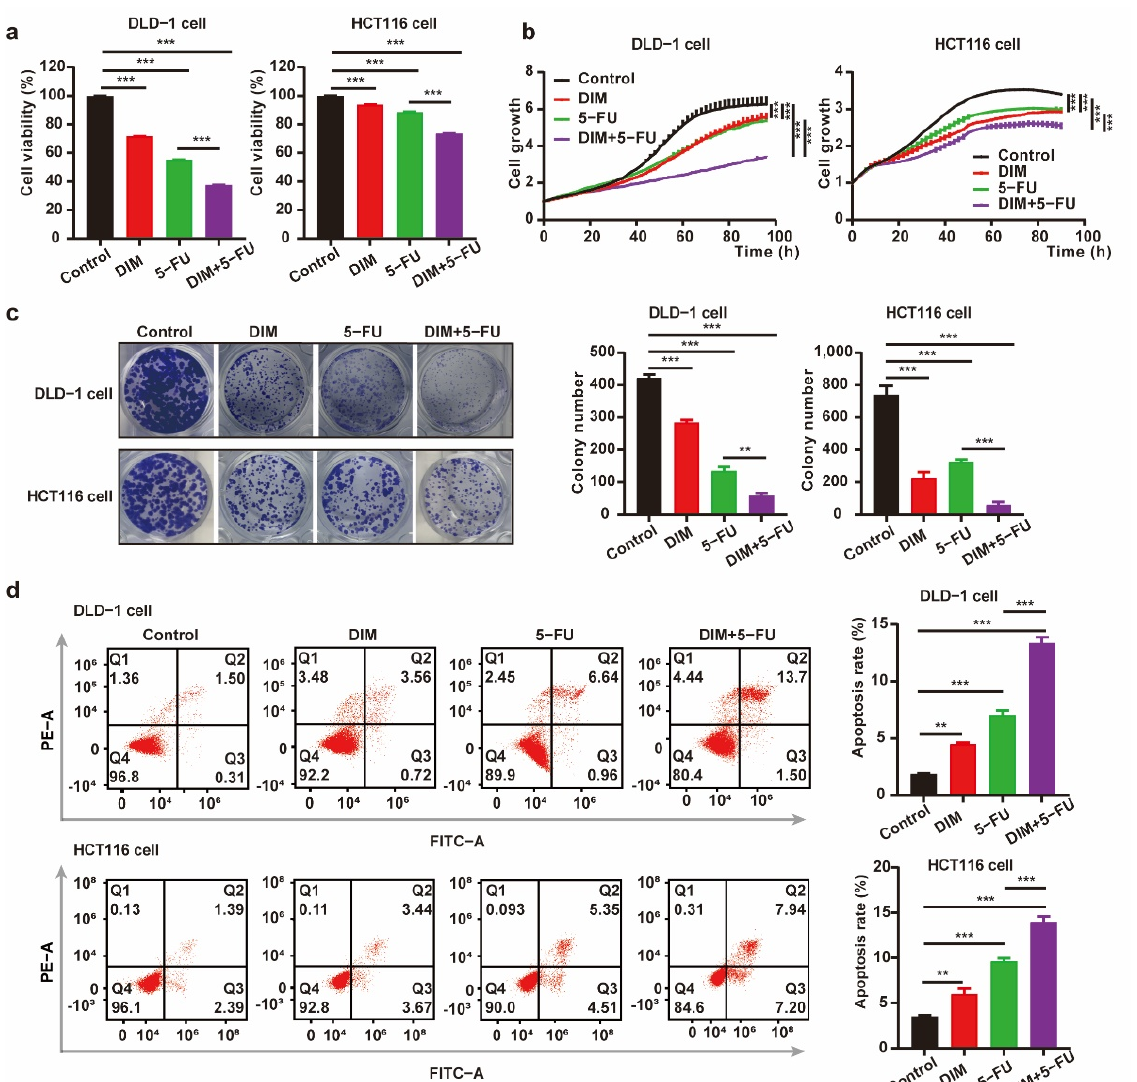
Figure 4. DIM increases the chemosensitivity to 5-FU and potentiates 5-FU-induced suppressive effect on CRC cells. ( a ) Cell viability of CRC cells was detected using CCK-8 assay. DLD-1 cells (DIM, 30 µ M; 5-FU, 10 µ M) and HCT116 cells (DIM, 20 µ M; 5-FU, 2.5 µ M) were treated with DIM for 48 h. ( b ) Relative cell growth in CRC cells treated with DIM, 5-FU, or the combination of DIM and 5-FU. DLD-1 cells (DIM, 30 µ M; 5-FU, 10 µ M) and HCT116 cells (DIM, 20 µ M; 5-FU, 2.5 µ M) were monitored throughout the whole process by the IncuCyte machine. ( c ) A colony formation assay treated with DIM and 5-FU alone or in combination was carried out using CRC cells. DLD-1 cells (DIM, 30 µ M; 5-FU, 10 µ M) and HCT116 cells (DIM, 20 µ M; 5-FU, 2.5 µ M) were plated in 12-well plates for 9 days. ( d ) Flow cytometry analysis of apoptosis in CRC cells pretreated with DIM and 5-FU (DLD-1 cell: 30 µ M DIM and 10 µ M 5-FU; HCT116 cell: 20 µ M DIM and 2.5 µ M 5-FU) for 48 h. The percentage value of Q2 + Q3 indicates the proportion of apoptotic cells. Data are presented as mean ± SEM. **, p < 0.01; ***, p < 0.001; two-way ANOVA